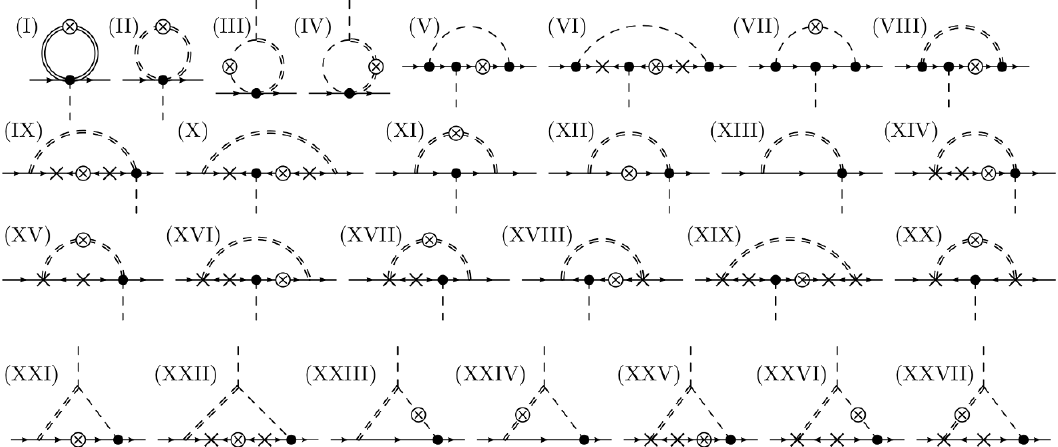
Figure 7 . Diagrams contributing to the Yukawa coupling constant in the Landau gauge ( (cid:11) ! 0) with (cid:12) = 0. The single-solid and broken lines exhibit fermion and scalar-boson ( (cid:30) ), respectively, while the double-solid and broken lines are spin 2 ( h TT ) and spin 0 ( h = (cid:22) g (cid:22)(cid:23) h (cid:22)(cid:23) ) gravitons, (cid:22)(cid:23) respectively. The cross in circle denotes the cuto(cid:11) insertion into the propagators, i.e. (cid:10) = @ t R k . The cross and black-point stand for the Majorana mass and the Yukawa coupling,